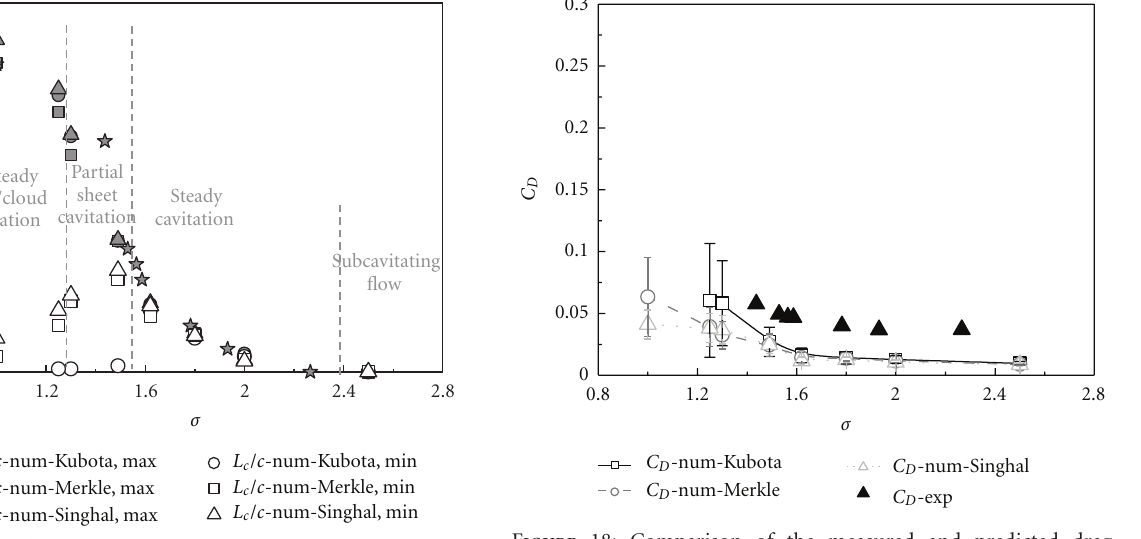
Figure 18: Comparison of the measured and predicted drag coe ffi cients ( C D ) for various cavitation numbers. Re = 750,000, α = 6 ◦ , and n = V ∞ = 5m/s,